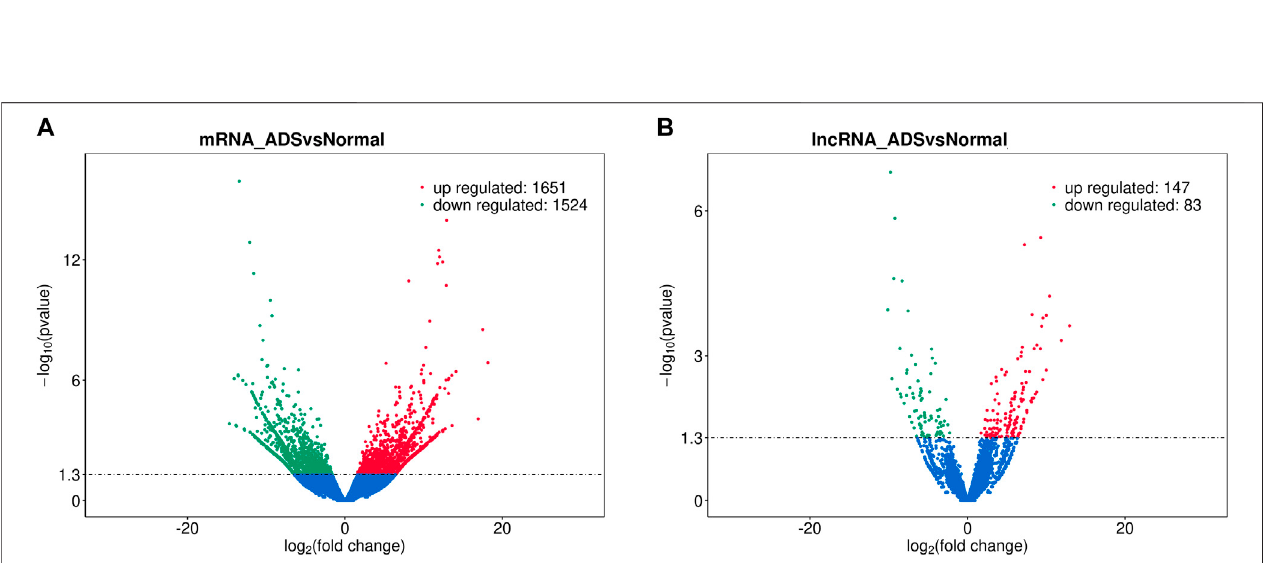
FIGURE 2 | Principal component analysis (PCA) shows the clustering of mRNA and long noncoding RNA (lncRNA) expression matrices in different samples. (A) PCAofmRNAexpressionbetweentheADSclusterandnormalcluster.ThereddotsrepresenttheADSsamples,andthebluedotsrepresentthenormaltissue(Normal) samples. (B) PCA ofthe lncRNA expression betweenthe ADS cluster and normal cluster.The red dots represent the ADS samples, and the blue dots represent Normal samples.